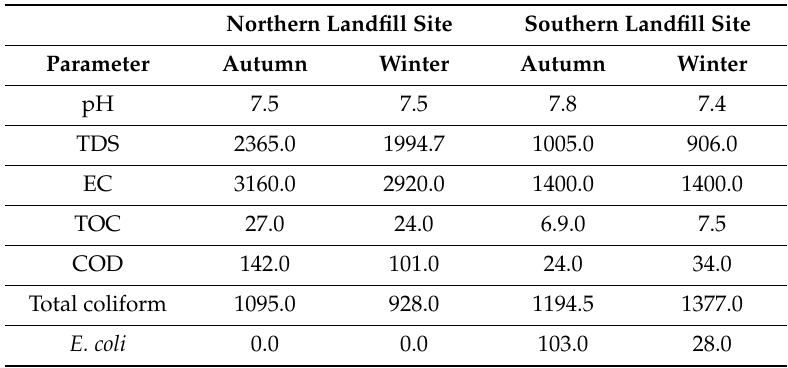
Table 2. Comparison of the average physicochemical and microbiological parameters of the two landfill sites over two seasons.